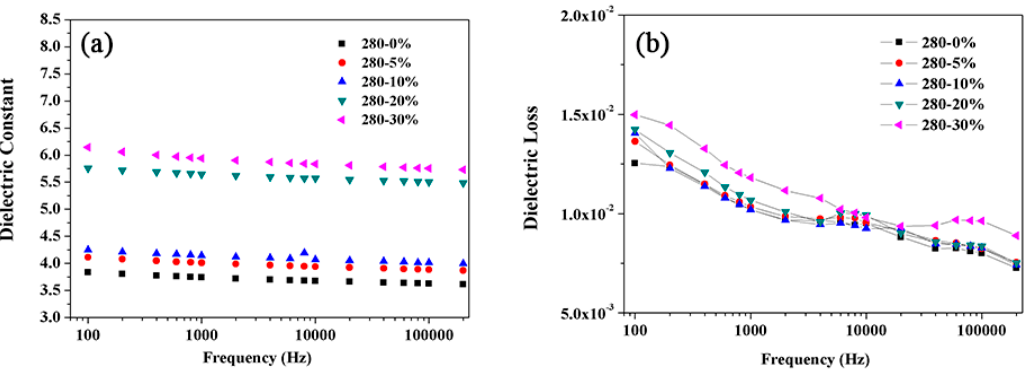
Figure 10. Dielectric constant ( a ) and dielectric loss ( b ) of BT@ZnPc-2/PEN films after isothermal annealing at 280 °C for 5 hours.